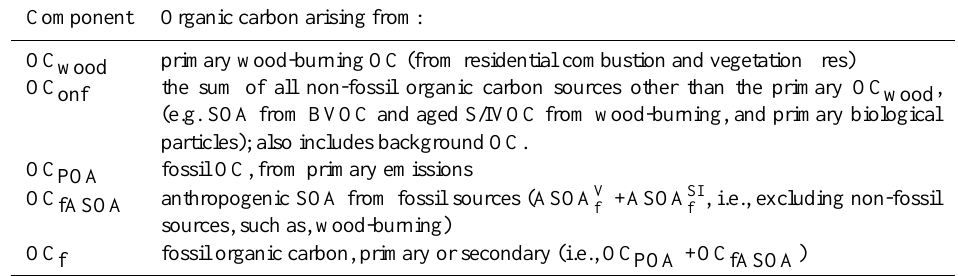
Table 5. Notation for organic aerosol components used in source-apportionment analysis.